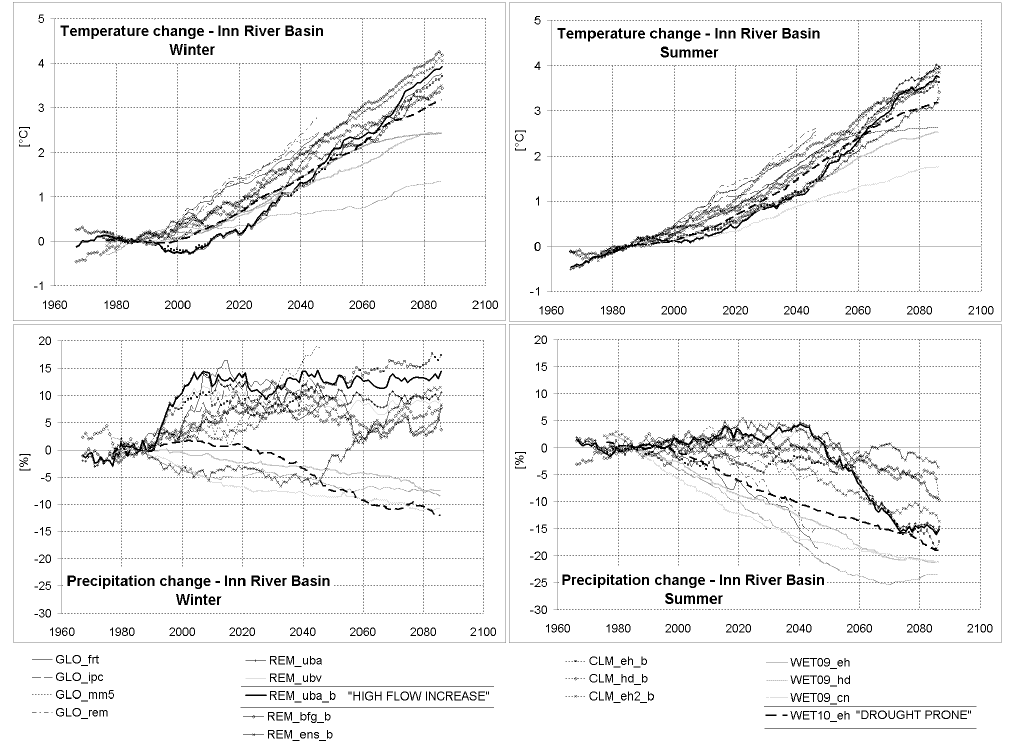
Fig. 4. Projected changes in temperature and precipitation in the Inn River basin; 30-yr-moving average vs. average for reference period (1971–2000) for hydrological winter season (November–April) and summer season (May–October); dashed black line: “drought-prone scenario” (WET10 eh), thick black line: “high-flow increase scenario” (REM UBA